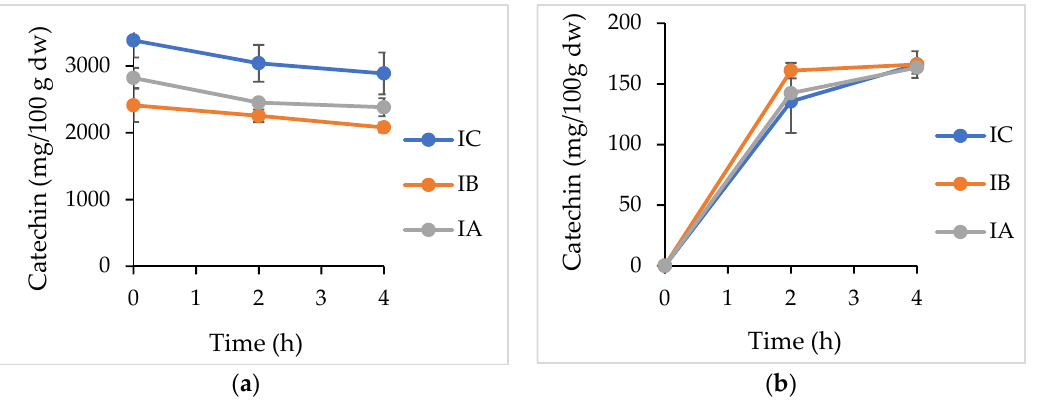
Figure 2. The apical ( a ) and basolateral ( b ) side concentration of catechin during 4 h of transportation. IC: infusion control sample, IB: infusion with bovine milk blend, IA: infusion with almond milk blend.